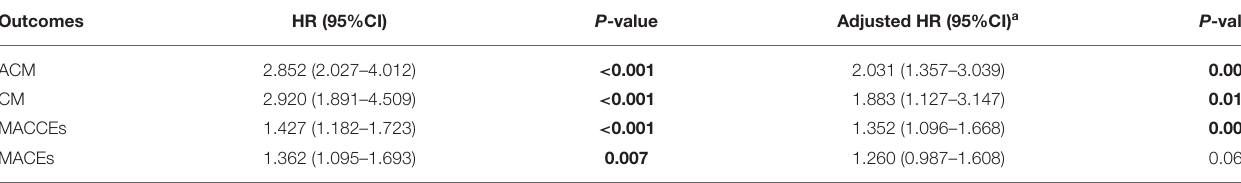
TABLE 3 | Univariate and multivariate COX regression analysis